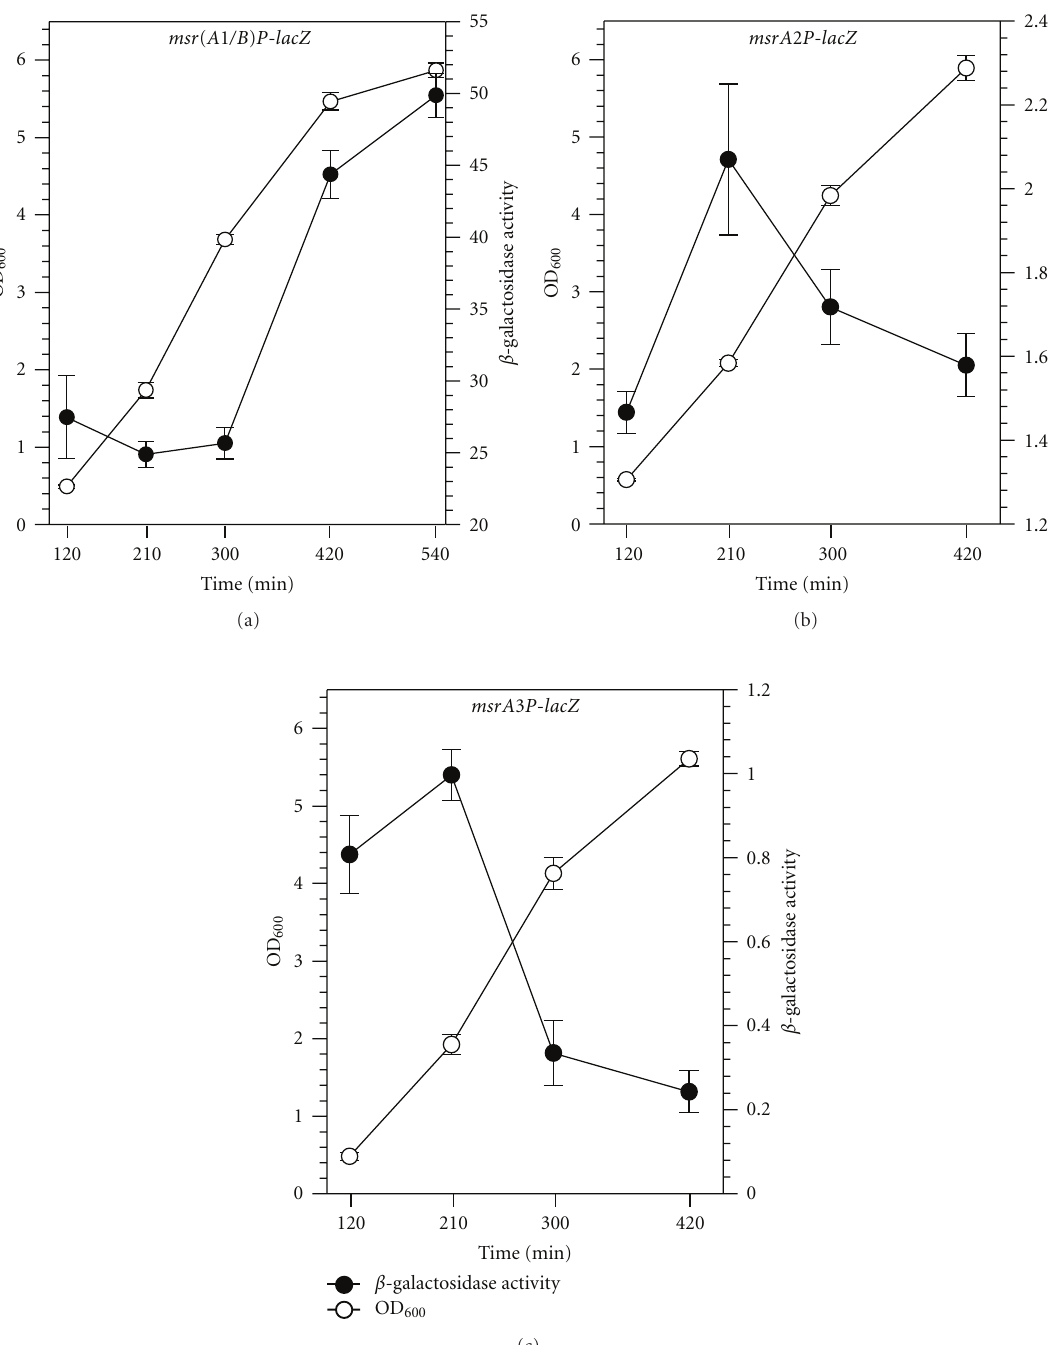
Figure 2: β -galactosidase activity levels in msr(A1/B)P-lacZ (a), msrA2P-lacZ (b), and msrA3P-lacZ (c) reporter strains during di ff erent stages of growth under standard growth conditions. Growth and β -galactosidase activity were measured at di ff erent time points spectrophotometrically. For precise OD 600 determination, the late-stage cultures were diluted appropriately to bring cell density in measurable range of the spectrophotometer. OD 600 is indicated by open circles, and β -galactosidase activity (OD 420 ) is indicated by closed circles. Values indicate averages of data from three independent experiments ± standard deviation